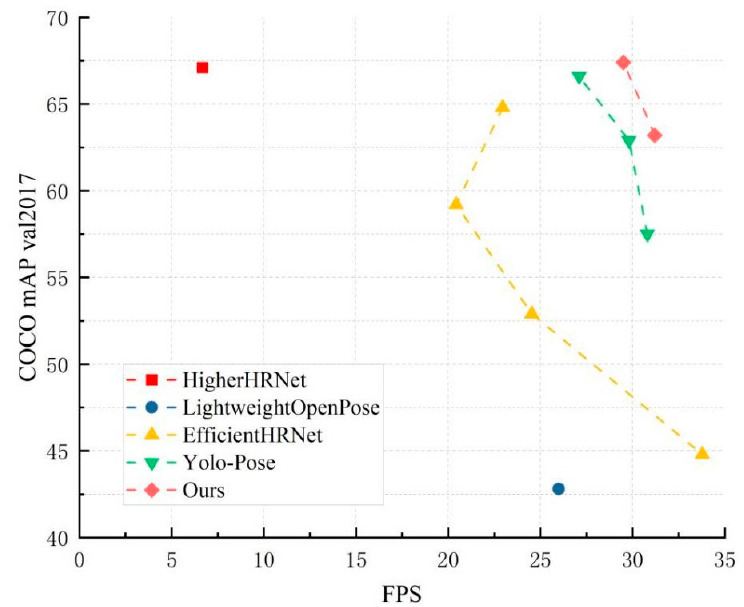
Figure 8. FPS vs. mAP of Different Methods on COCO 2017 Validation Dataset.